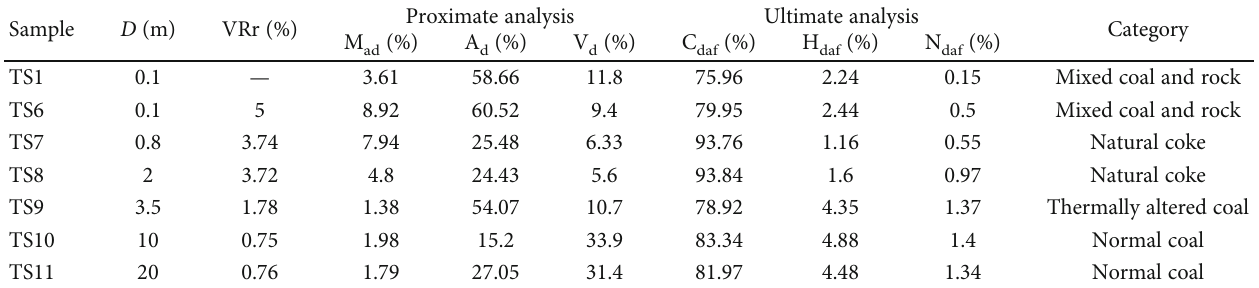
Table 1: VRr results and proximate and ultimate analysis data of thermally altered coal and normal coal samples. Sample